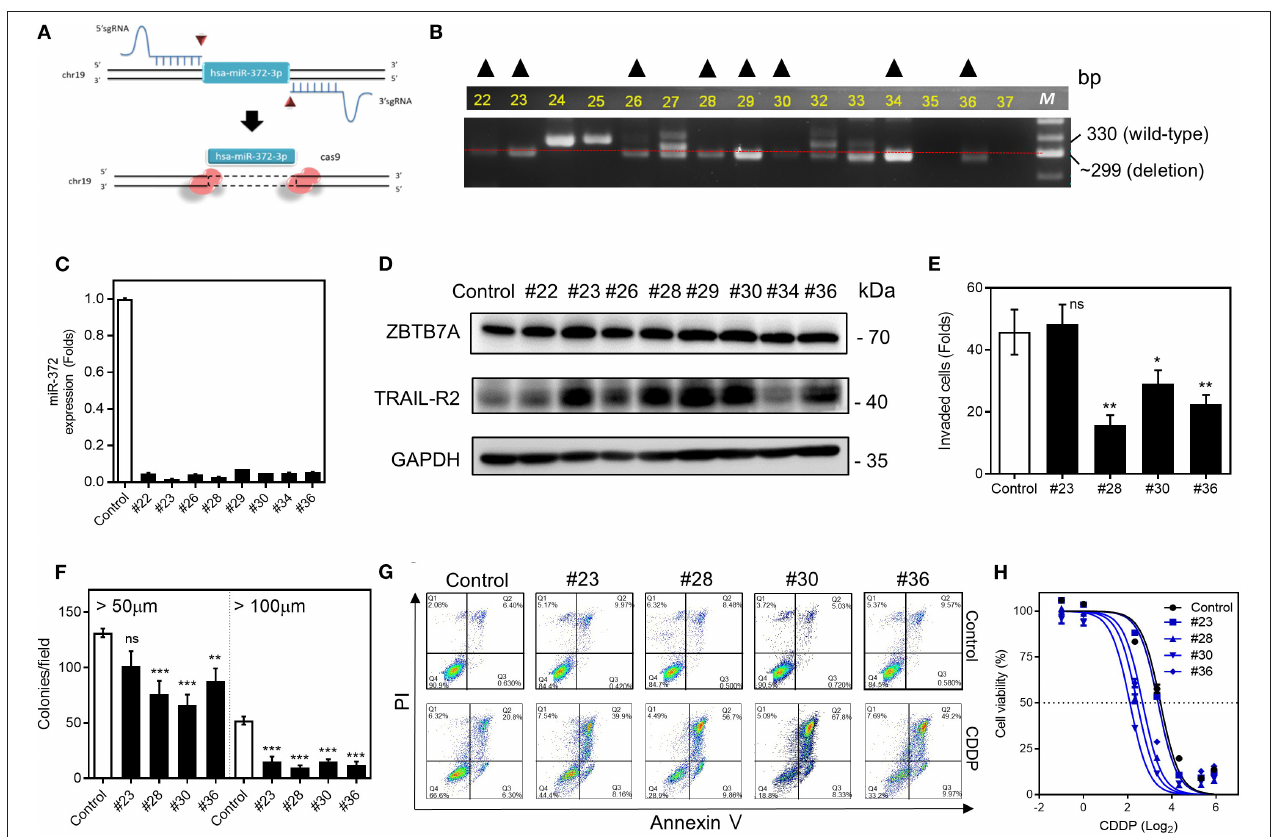
FIGURE 6 | miR-372 associated oncogenicity and CDDP resistance in SAS cells. (A) 5 ′ sgRNA and 3 ′ sgRNA are designed to delete hsa- miR-372 -3p. (B) PCR analysis is used to screen the deletion cell subclones. The dotted line indicates the ∼ 300-bp position on the gel electrophoresis image. Cell subclones exhibiting a band below the dotted line and the absence other bands (marked by triangles) are suspected to have a homozygous deletion. (C) qRT-PCR analysis. This reveals almost complete absence of miR-372 expression in the sublcones selected in (B) . (D) Western blot analysis revealing the upregulation of ZBTB7A, TRAIL-R1, and TRAIL-R2 expression in nearly all subclones except for subclone #34. (E,F) Invasion assay and anchorage-independent colony formation assay, respectively. The assays show the general decrease of these properties in the deleted subclones that are tested. (G) Flow cytometry analysis to detect apoptosis. The CDDP induced apoptosis is higher in deleted subclones relative to the control cells. (H) Cell viability assay. The miR-372 deleted cell subclones exhibit higher sensitivity to CDDP. ns , not significant; * p < 0.05; ** p < 0.01; *** p <